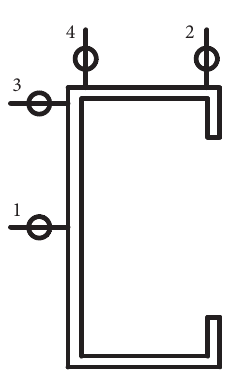
Figure 5: Measured locations for initial geometric